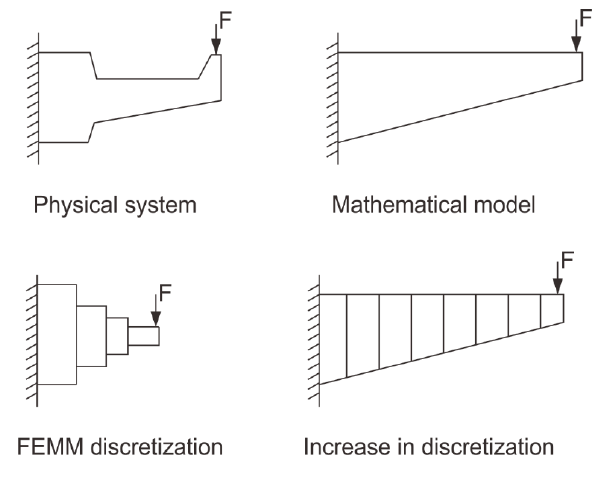
Figure 1: Approximate nature of finite-element analysis (FEA)